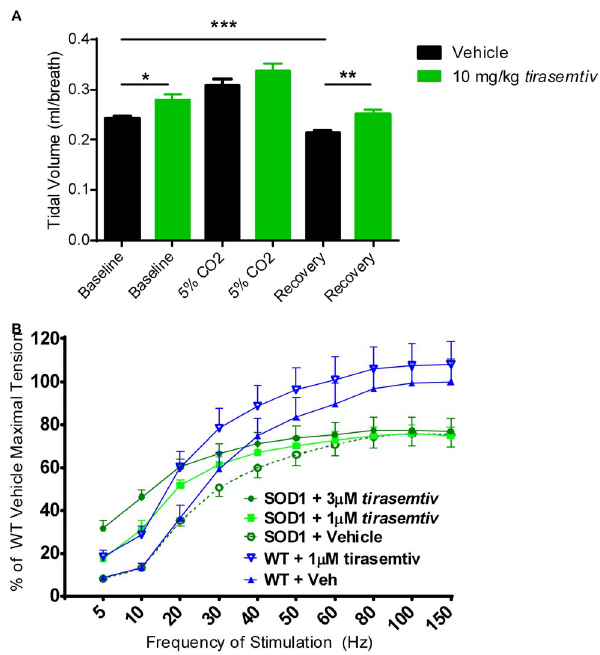
Figure 7. Tirasemtiv increases tidal volume and submaximal diaphragm tension in late stage female B6SJL-SOD1 G93A mice. Respiratory function and diaphragm tension output were assessed in B6SJL-SOD1 G93A mice at 18 weeks of age. (A) B6SJL-SOD1 G93A mice dosed with tirasemtiv had significantly higher tidal volume than vehicle- dosed mice at baseline and during recovery following a 5% CO 2 exposure. Compared to its baseline tidal volume, vehicle-treated B6SJL- SOD1 G93A mice had significantly lower tidal volume during recovery. (B) Harvested WT and B6SJL-SOD1 G93A diaphragms treated with tirasemtiv produced greater tension in response to submaximal frequencies of electrical stimulation. Data are expressed as mean 6 SEM. n $ 5/group.